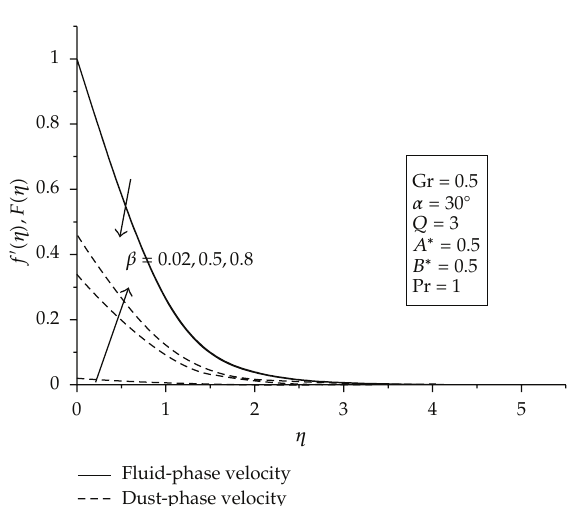
Figure 2: Velocity profile for di ff erent values of fluid-particle interaction parameter.